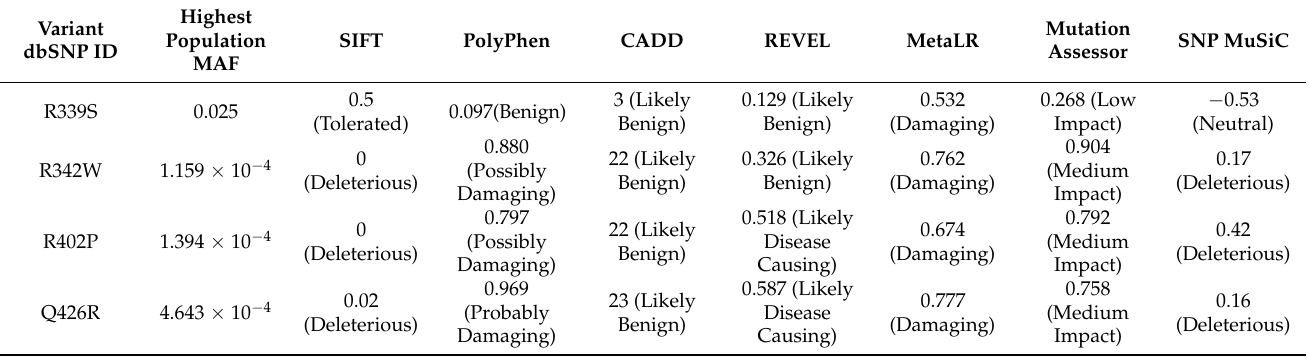
Table 1. Selected known single nucleotide variants of hOtolC1q, their prevalence and predictions of deleteriousness. The data were retrieved from the Ensembl database, and for SNPMuSiC independently calculated based on the SAXS-derived model of hOtolC1q trimer (https://soft.dezyme.com/, accessed 16 August 2021)